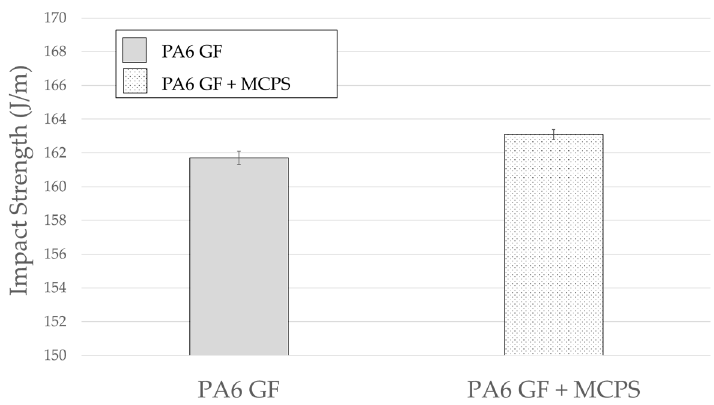
Figure 19. Effect of MCPs on impact strength.